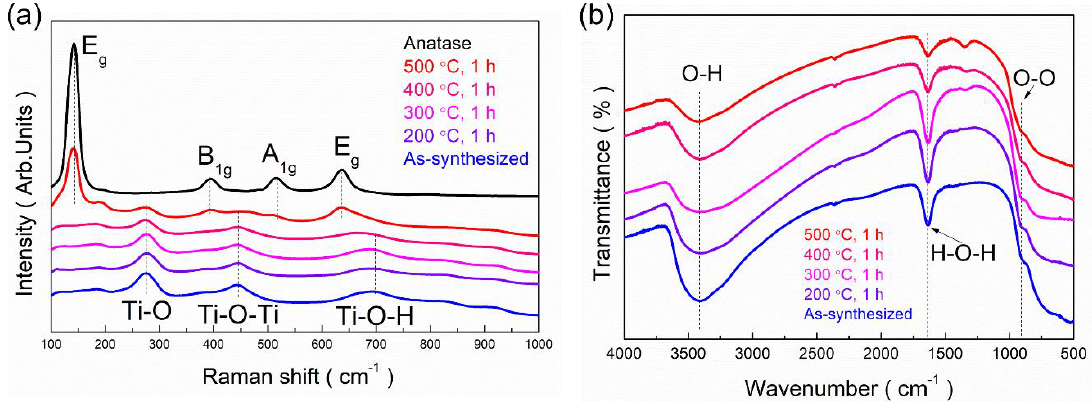
Figure 7. ( a ) Raman spectra and ( b ) Fourier transform infrared (FT-IR) spectra of the as-synthesized PTNTs and annealed PTNTs at different temperatures.